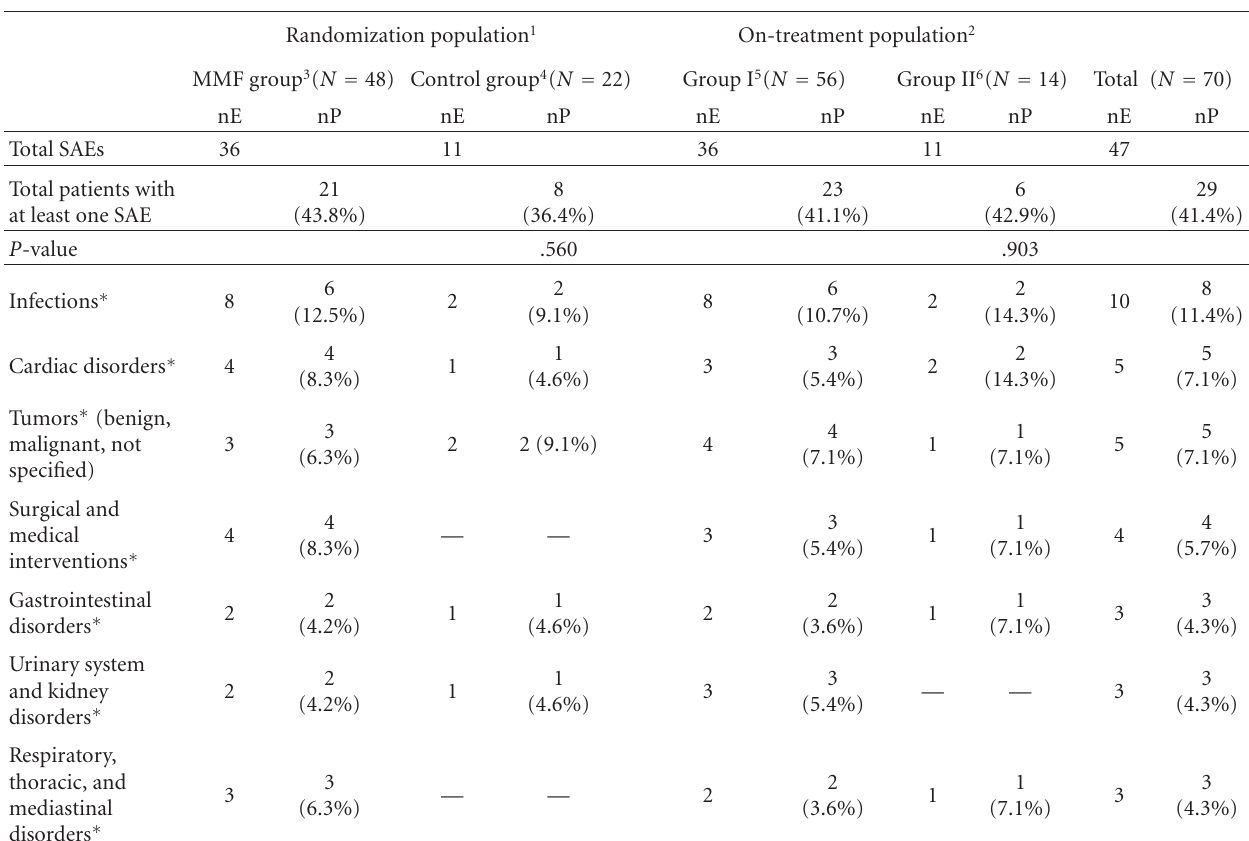
Table 4: Serious Adverse Events (SAEs) during the three-year post-trial phase. Randomization population